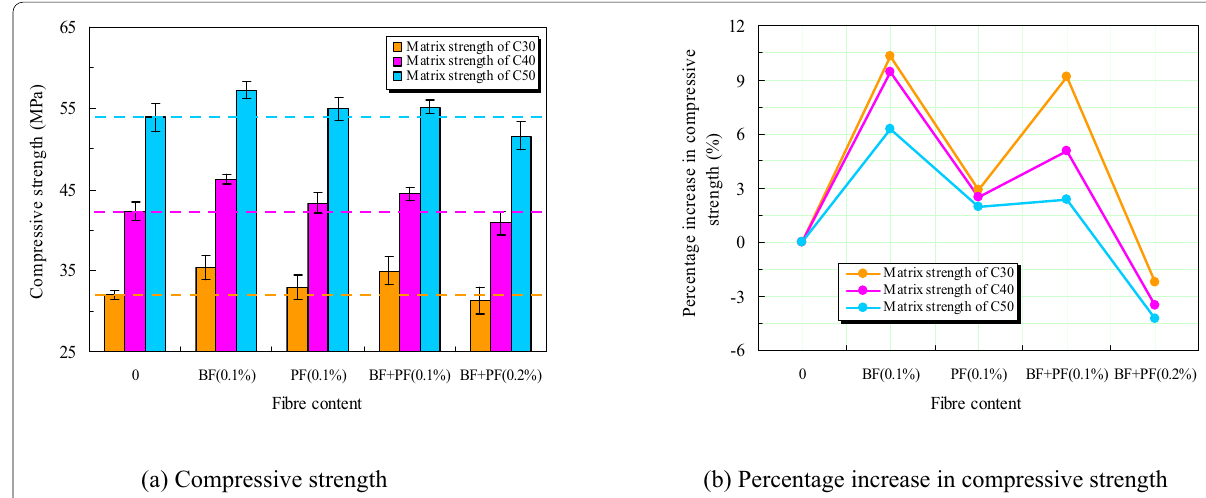
Fig. 5 Variation on the compressive strength of